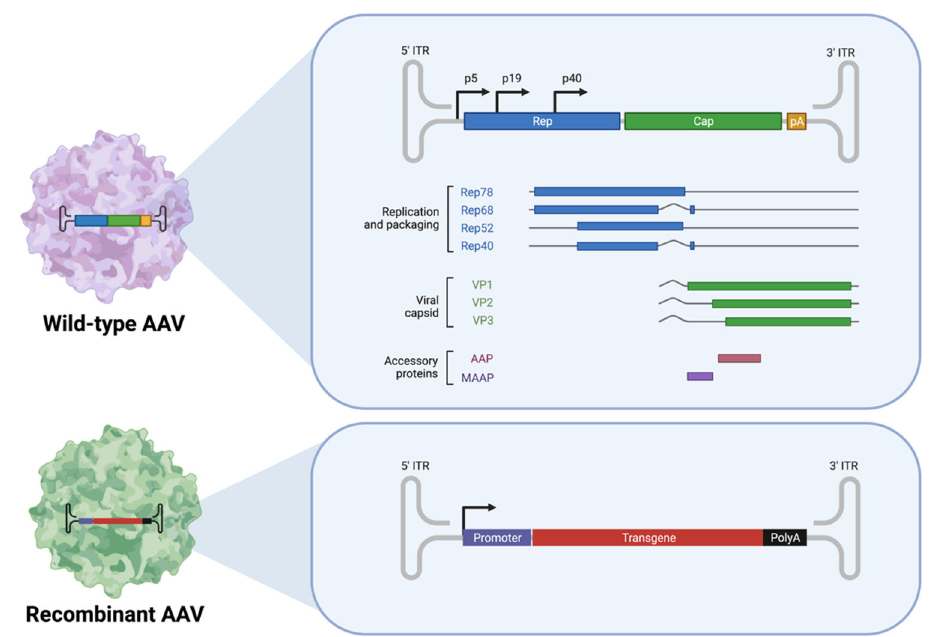
Figure 2. Schematic of the wild type and recombinant AAV genome. The wild type AAV genome comprised four known open reading frames, rep (blue), cap (green), MAAP (burgundy), and AAP (purple), flanked by inverted terminal repeats (ITRs, grey color). The rep gene encodes four regulatory proteins: Rep78, Rep68, Rep52, and Rep40. Cap gene encodes viral proteins, VP1, VP2, and VP3. Rep and cap genes are removed from the genome of recombinant AAV, instead the transgene expression cassette was inserted, flanked by ITRs. Created with BioRender.com.